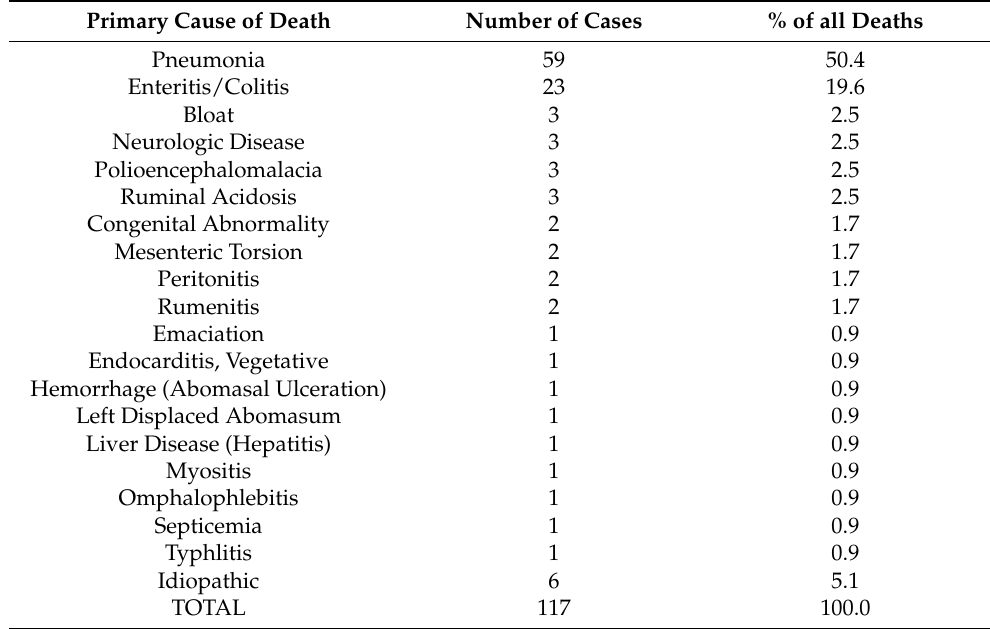
Table 5. Primary cause of death of 117 calves 2 months to 5 months old diagnosed at